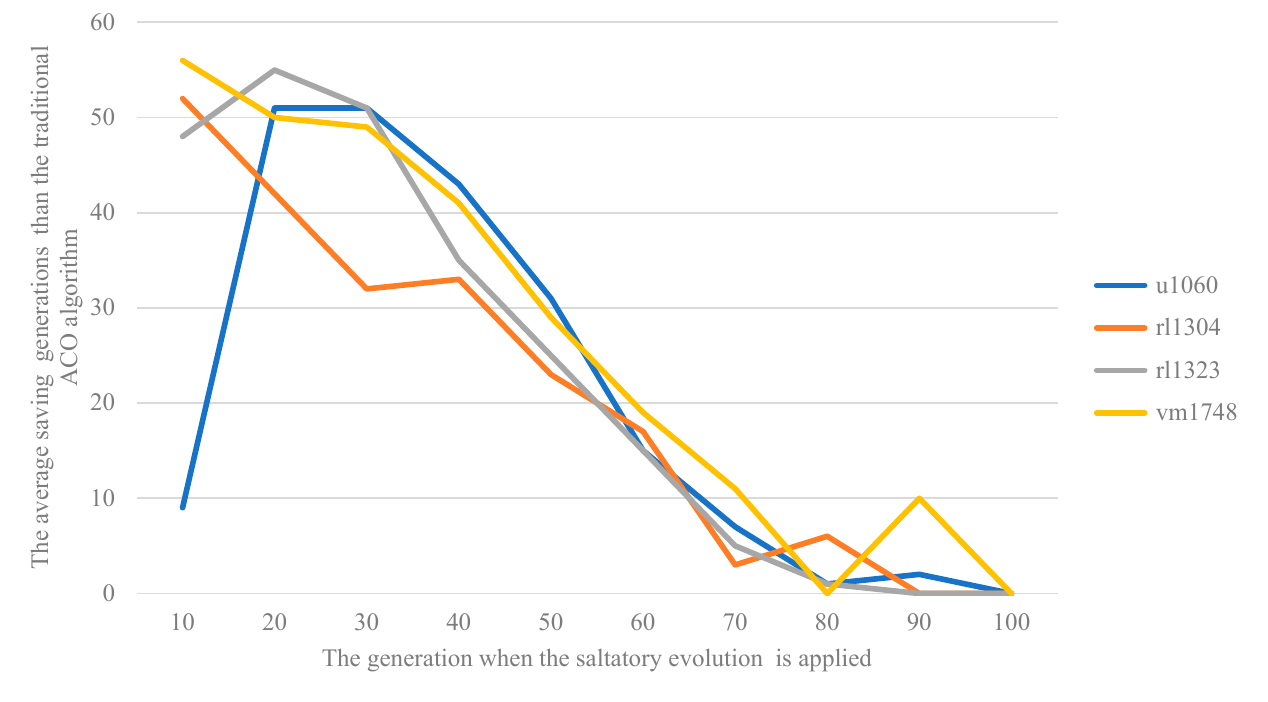
Figure 9. The optimization results of SEACO algorithm for data sets where n is in (800, 2000].